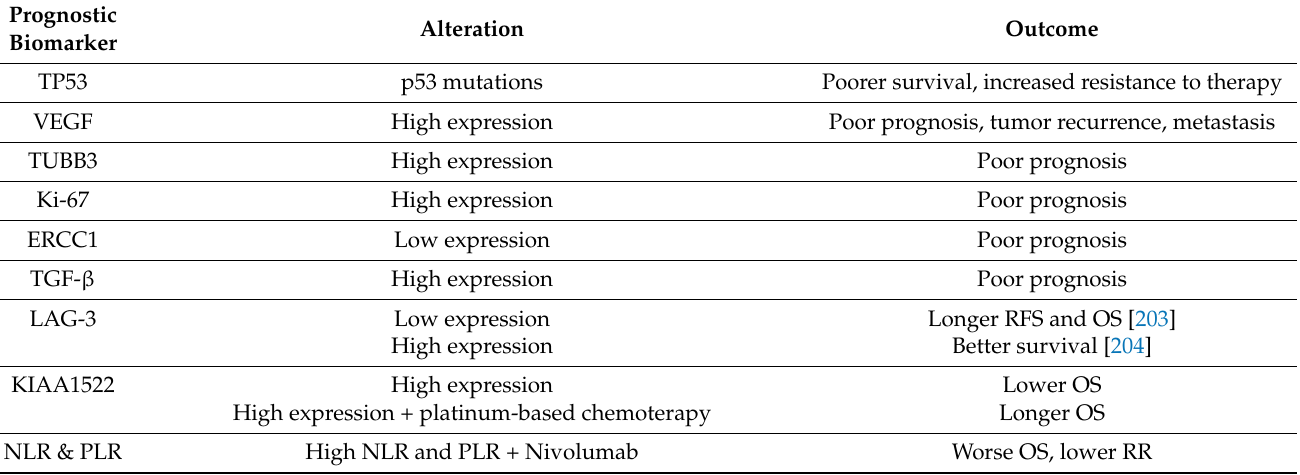
Table 5. Summary of novel prognostic